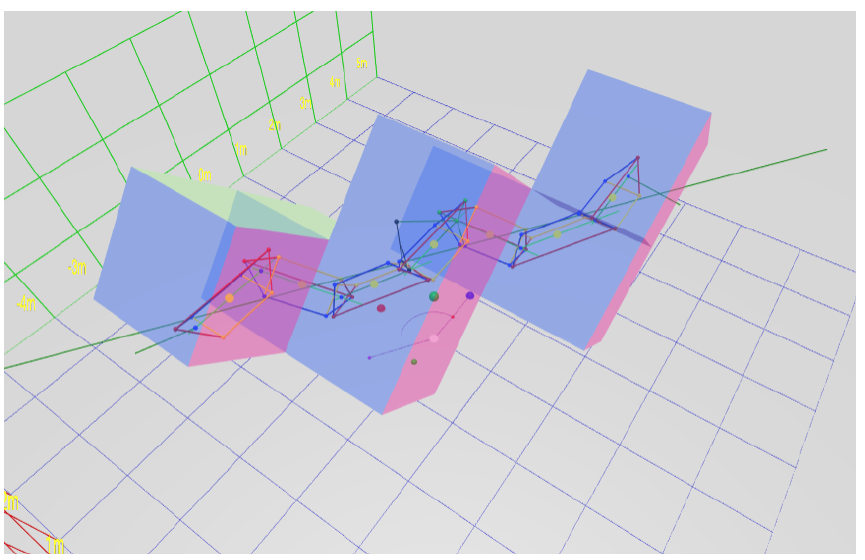
Figure 13. The Blockhelix.